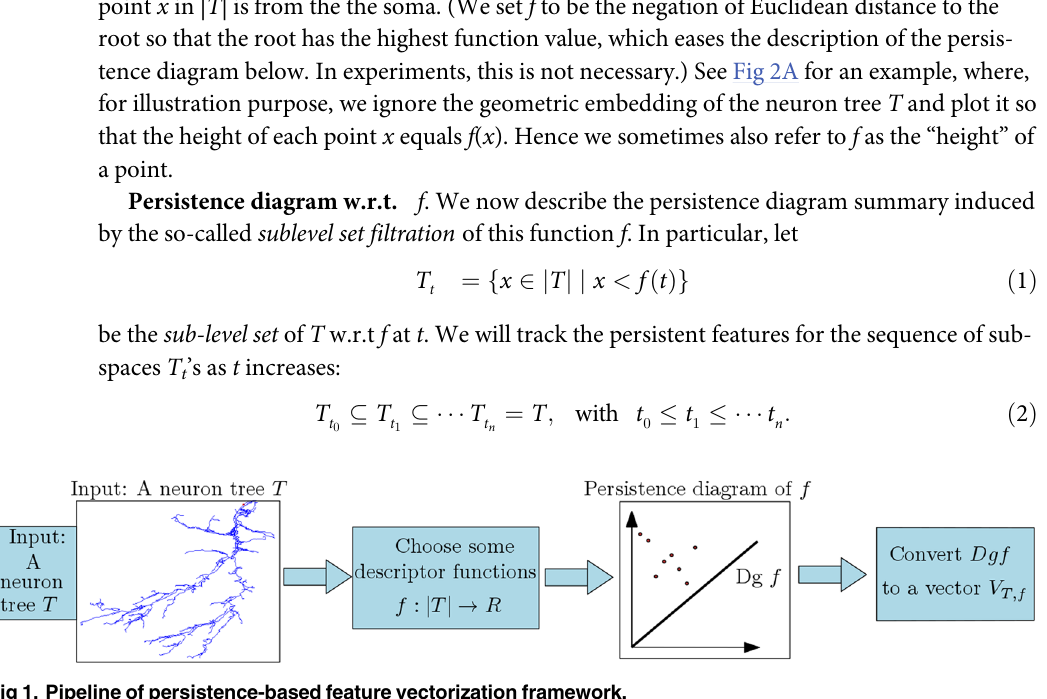
Fig 1. Pipeline of persistence-based feature vectorization